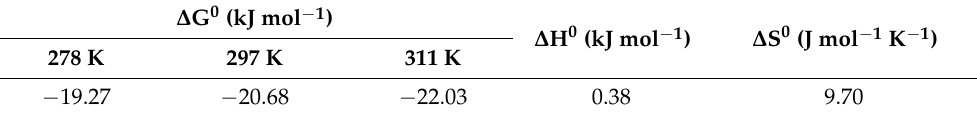
Table 4. The thermodynamic parameters for the dye adsorption on raspberry leaf powder.